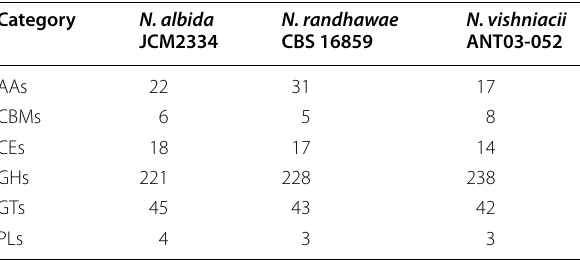
Table 2 Overview of CAZyme and number of gene families in each CAZyme category across the genomes of Naganishia